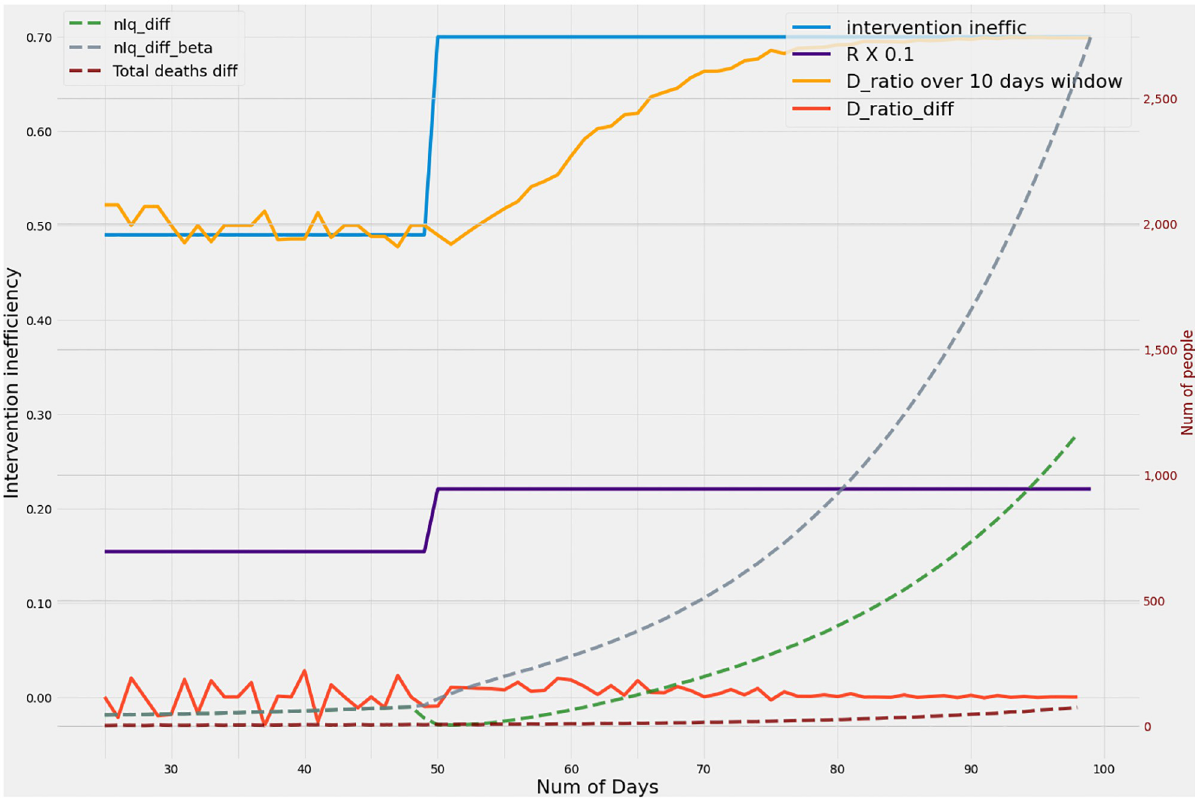
Fig 4. The graph considers the rise in active cases due to two scenarios, both of which result in identical changes in reproduction number R. When the rise in R is due to an increase in β , the active case increase yields a sharper curve giving a true indication of underlying cases. However, when the the increase in R is due to increase in test-track-trace inefficiency, the rise in active cases are slower and in fact even decrease over the short term as the increasing cases are missed due to high inefficiency. A noticeable increase in active cases can only be seen past 30–40 days after the change. However, the increase in D ratio is already evident in 10 days from the day inefficiency increases and stabilizes within a period of 20 days. Complete convergence as defined in Fig 4 comes around 35 days. It may thus be seen that the maximum convergence times of D ratio metrics are comparable to the early rises in active case load based metrics. Thus windowed D ratio based metrics are ideally suited as triggers for initiating